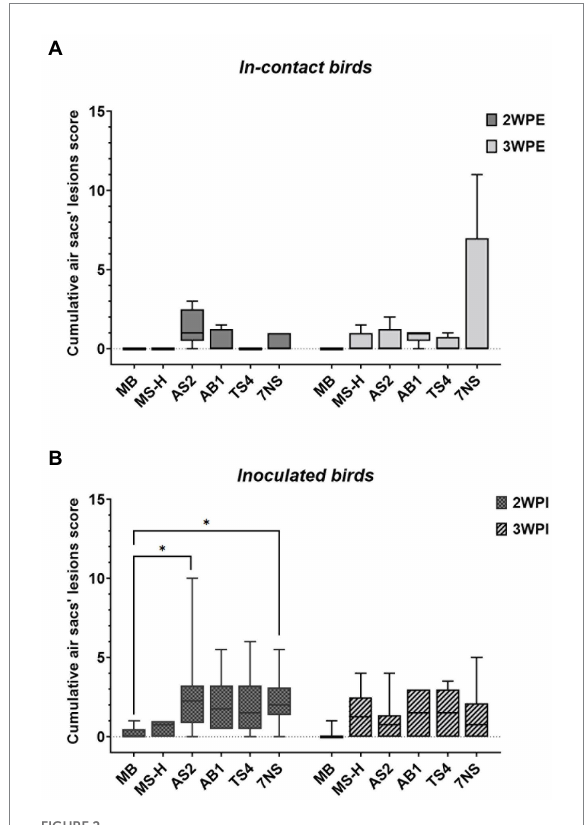
FIGURE 2 Box plots showing the data range (boxes: upper and lower quartile, whiskers: minimum and maximum) and line indicating the median value of the scores of the gross air sac lesions, 2- and 3-week after exposure of in-contact chickens to inoculated chickens (A) , and 2- and 3-week after aerosol inoculation of chickens with various strains or reisolates of M. synoviae following intratracheal inoculation of virulent IBV (B) . Air sac lesions were scored grossly for severity on a scale of 0–3, and a cumulative score was determined for each chicken by adding the scores of all air sacs. * p < 0.01 (Dunn’s corrected Kruskal– Wallis test). WPI, weeks post inoculation; WPE, weeks post exposure; AS2, MS-H reisolate containing reversion in obgE gene; AB1, MS-H reisolate containing reversions in obgE and oppF genes; TS4, MS-H reisolate containing reversions in obgE , oppF and gapdh